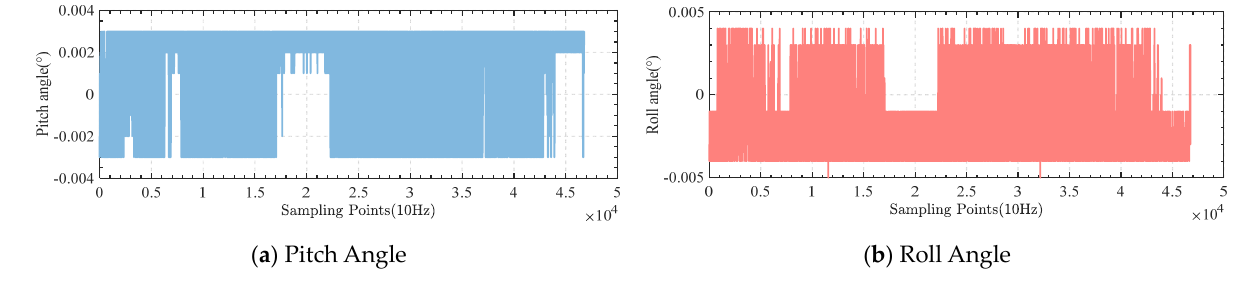
Figure 19. Vehicle experimentation results.